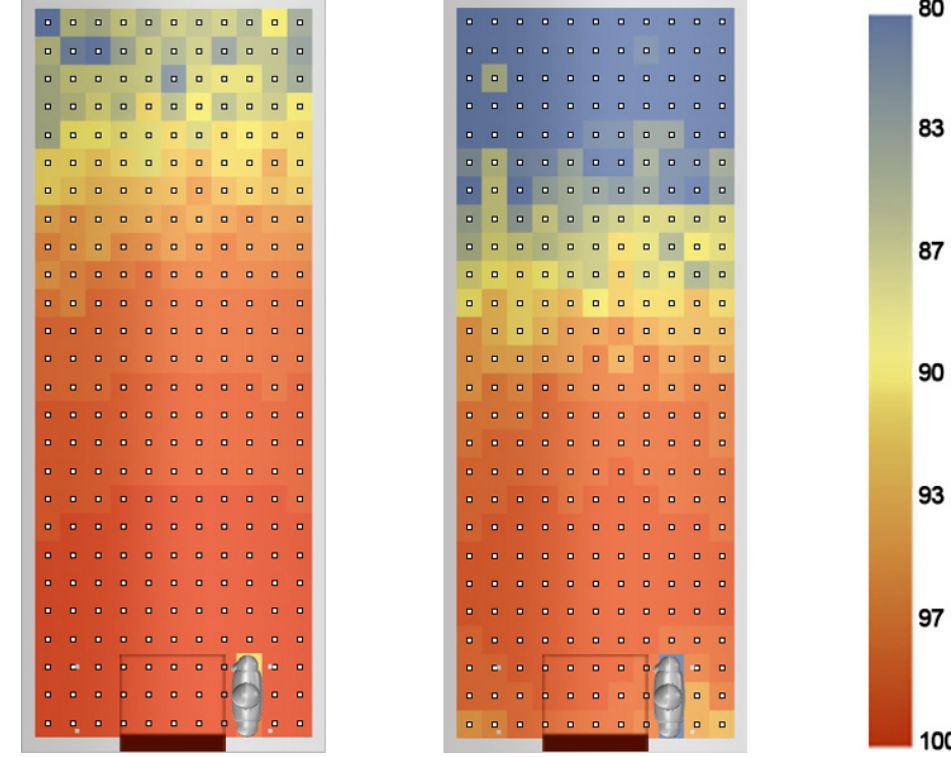
Figure 13. Daylight autonomy (DA) distribution; on the left, highly glazed façade system; and on the right, window combined by prismatic film CFS façade system.